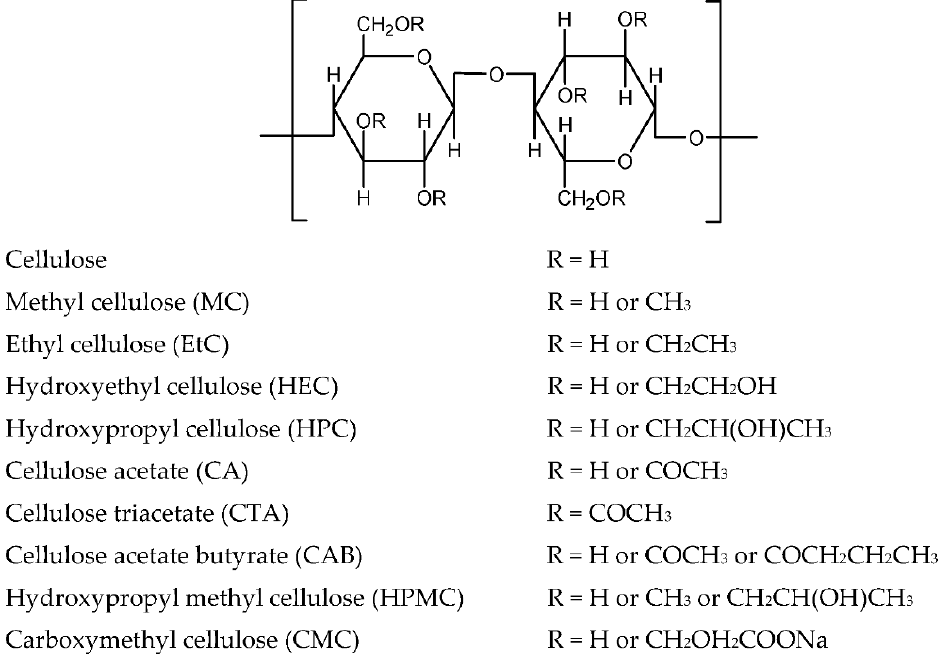
Figure 5. Representative units of cellulose and cellulose derivatives.